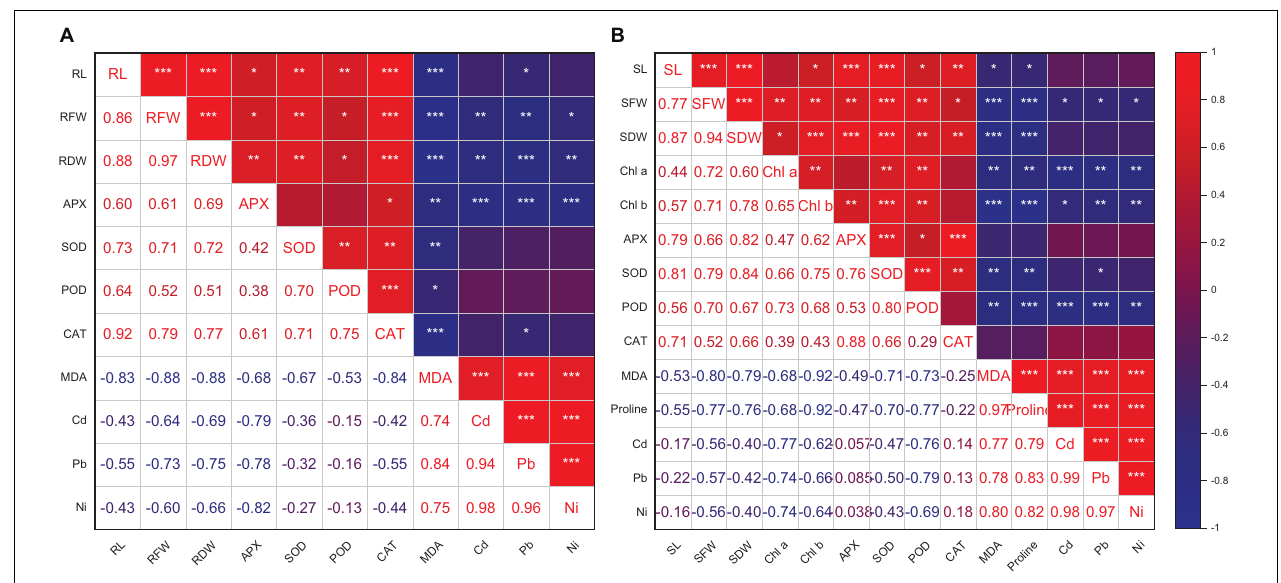
FIGURE 9 | Pearson’s correlation coefficient ( r ) of growth attributes and antioxidant enzymes of wheat root (A) and shoot (B) with and without the inoculation of heavy metal–resistant plant growth–promoting bacteria under Cd, Ni, and Pb stress. RL (root length), RFW (root fresh weight), and RDW (shoot dry weight). SL, shoot length; SFW, shoot fresh weight; SDW, shoot dry weight; Chl a, chlorophyll a; Chl b, chlorophyll b. * p ≤ 0.05, ** p ≤ 0.01, *** p ≤ 0.001.